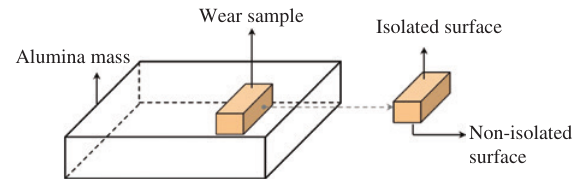
Figure 2: Schematic of the wear test specimen in alumina mass.